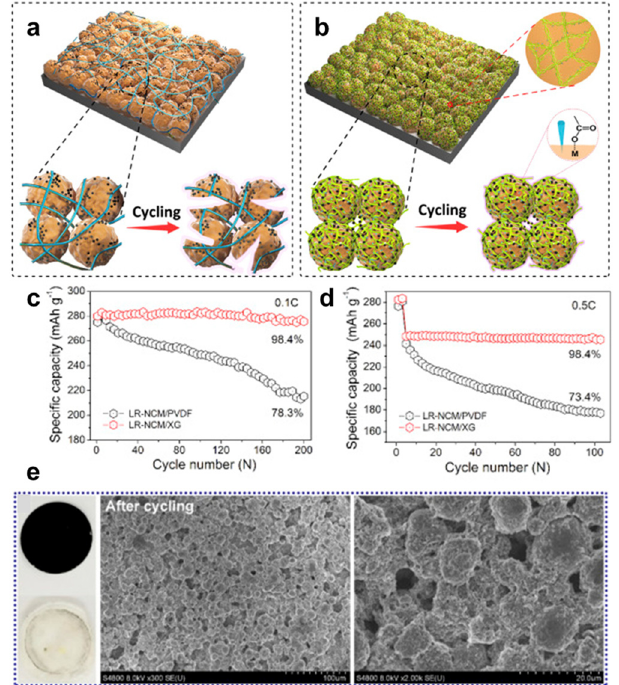
Figure 4. Schematic illustration on the postmortem morphology of Li[Li 0.144 Ni 0.136 Co 0.136 Mn 0.544 ]O 2 after cycling using ( a ) PVDF and ( b ) XG as a binder. Cycle retention characteristics of Li[Li 0.144 Ni 0.136 Co 0.136 Mn 0.544 ]O 2 at ( c ) 0.1 C and ( d ) 0.5 C with a PVDF and XG binder. ( e ) Ex situ SEM images of Li[Li 0.144 Ni 0.136 Co 0.136 Mn 0.544 ]O 2 with XG as a binder after cycling, along with photographs of electrode (left top) and separator (left bottom) [58].